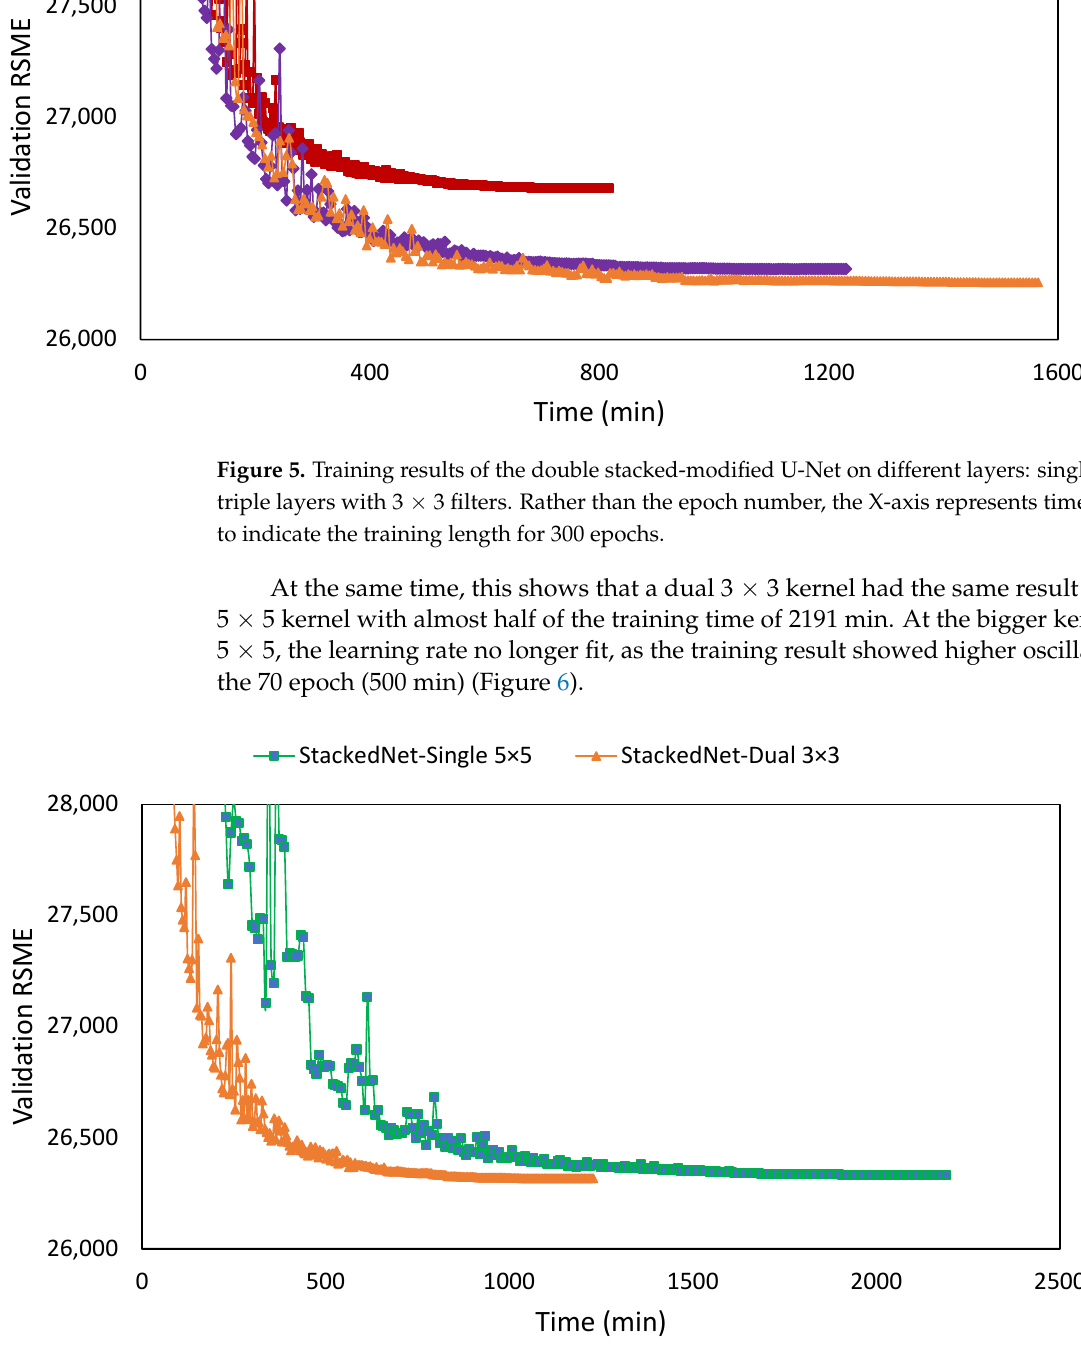
Figure 6. Training results of the double stacked-modified U-Net compare a dual layer with 3 × 3 filters and a single layer with 5 × 5 filters. Rather than the epoch number, the X-axis represents time in minutes to show the training length for 300